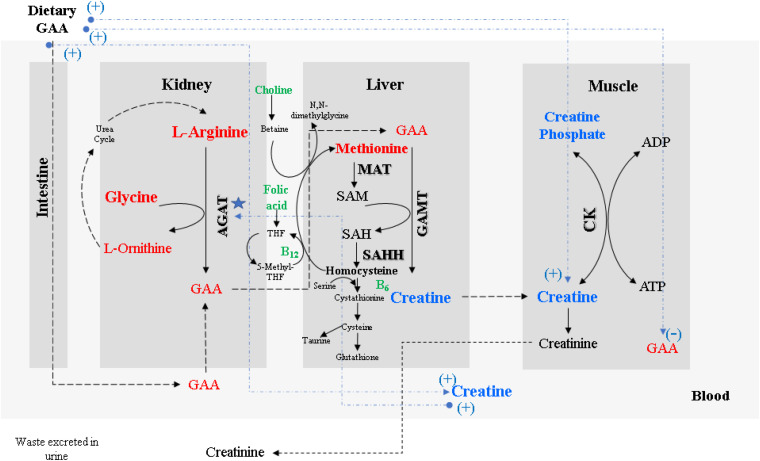
Metabolism of GAA and formation of muscular creatine. Dashed lines in blue color show the expected responses of GAA supplementation on broiler muscle and blood GAA and creatine concentrations. (Adapted from Wyss and Kaddurah-Daouk, 2000; Krueger et al., 2010; European Food Safety Authority [EFSA], 2016; Ostojic, 2016).